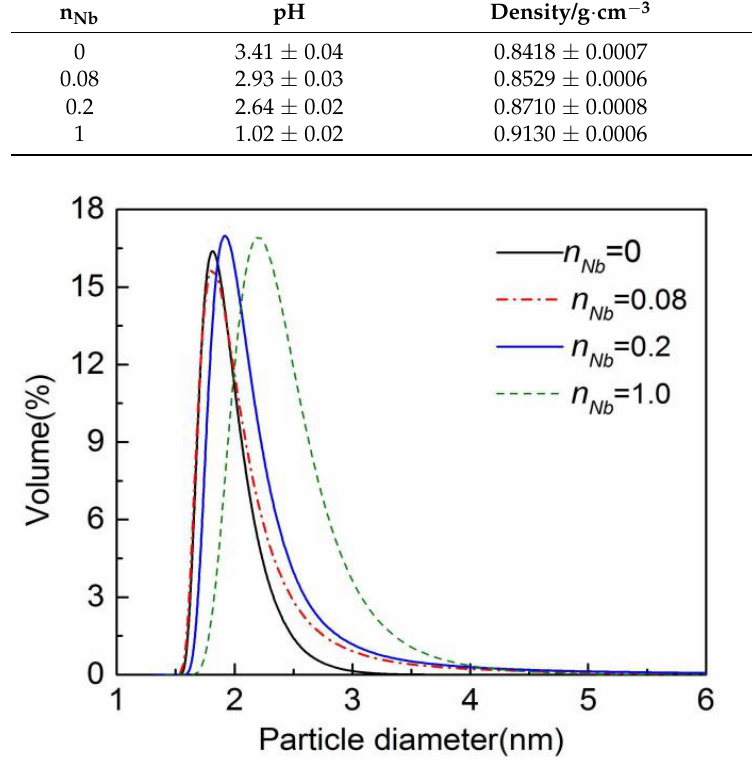
Figure 3. The particle size distributions of Nb/SiO 2 sols with various n Nb .